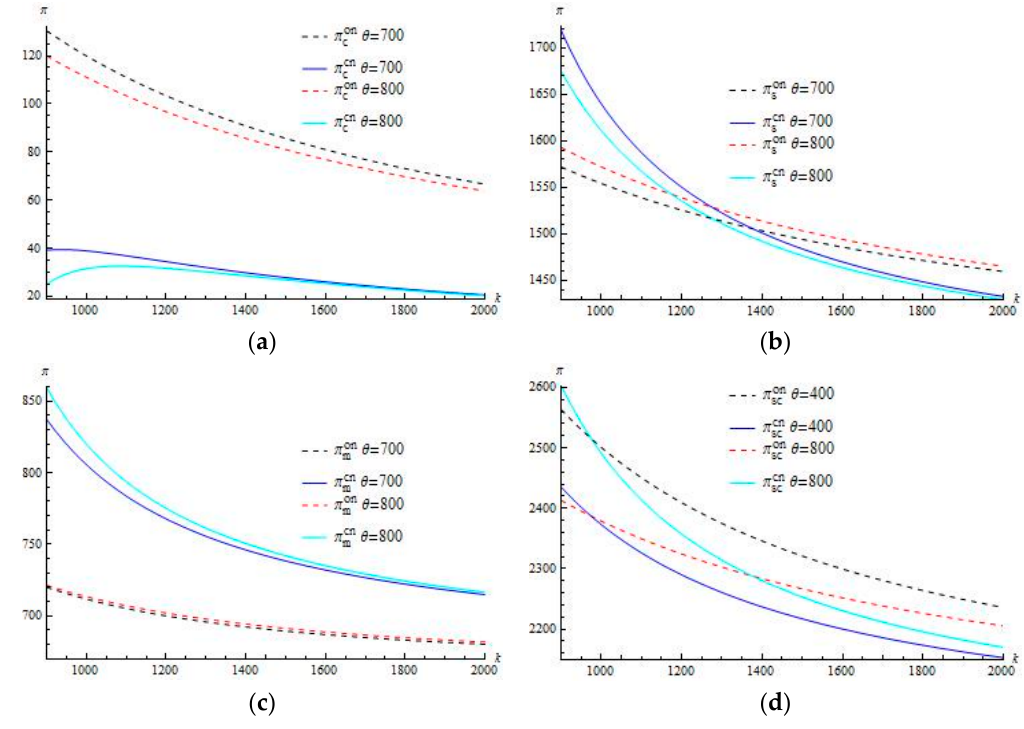
π π cn on and as k varies; ( b ) Comparing s c c π π cn on and as k varies; ( d ) Comparing m m